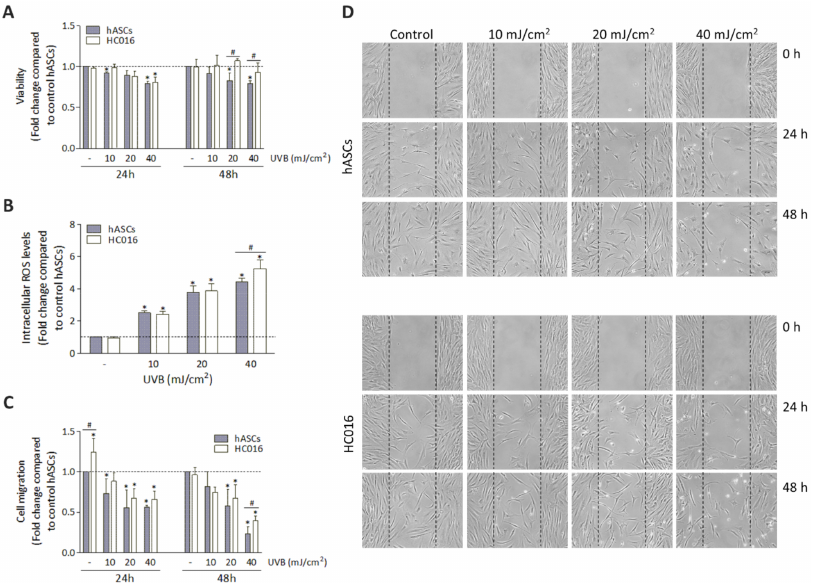
Figure 2. Effect of H 2 O 2 -preconditioning on hASC response to UVB radiation. ( A ) Viability of hASCs and HC016 cells, 24 and 48 h after UVB exposure. ( B ) ROS generation was induced by UVB radiation and measured by H2DCF-DA staining at 1 h. ( C ) Quantitative data on cell migration: fold difference in cell count. ( D ) Representative photomicrographs of cell migration at 0, 24 and 48 h after irradiation. The dashed lines indicate the wound edges (scale bar: 50 µ m). Values were normalized to non-irradiated control hASCs (dotted line) and expressed as mean ± SD. * p < 0.05 with respect to the control of non-irradiated hASCs; # p < 0.05 between hASCs and HC016 cells.